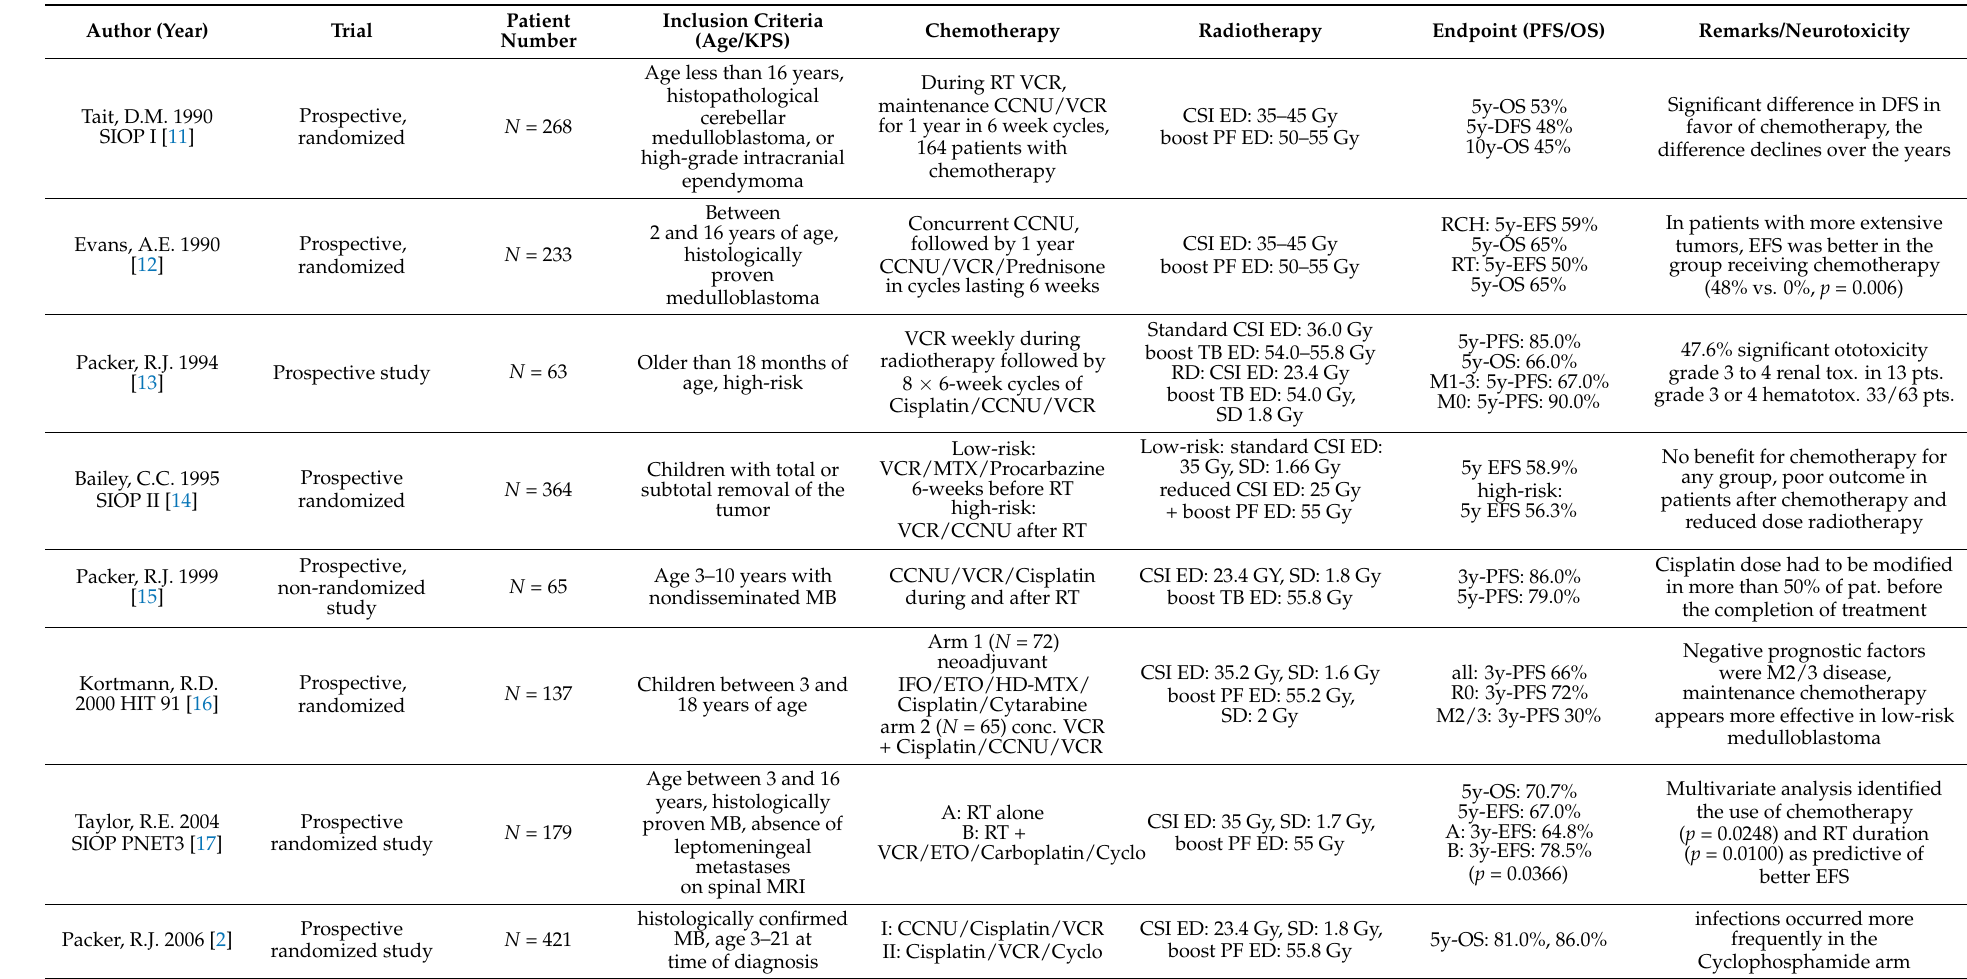
Table 1. Efficacy of radiochemotherapy in medulloblastoma in children—results of large randomized